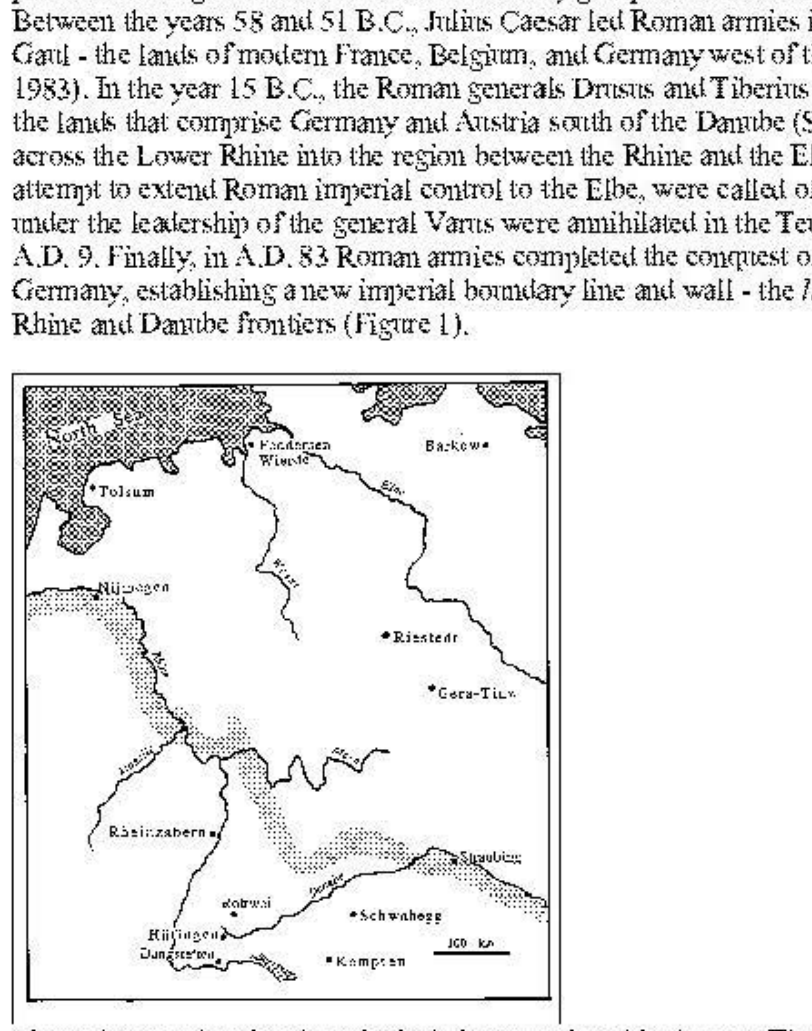
Figi:trc 1. Map shownlg the principal sites mentioned iJ.1 the text. The shallcd